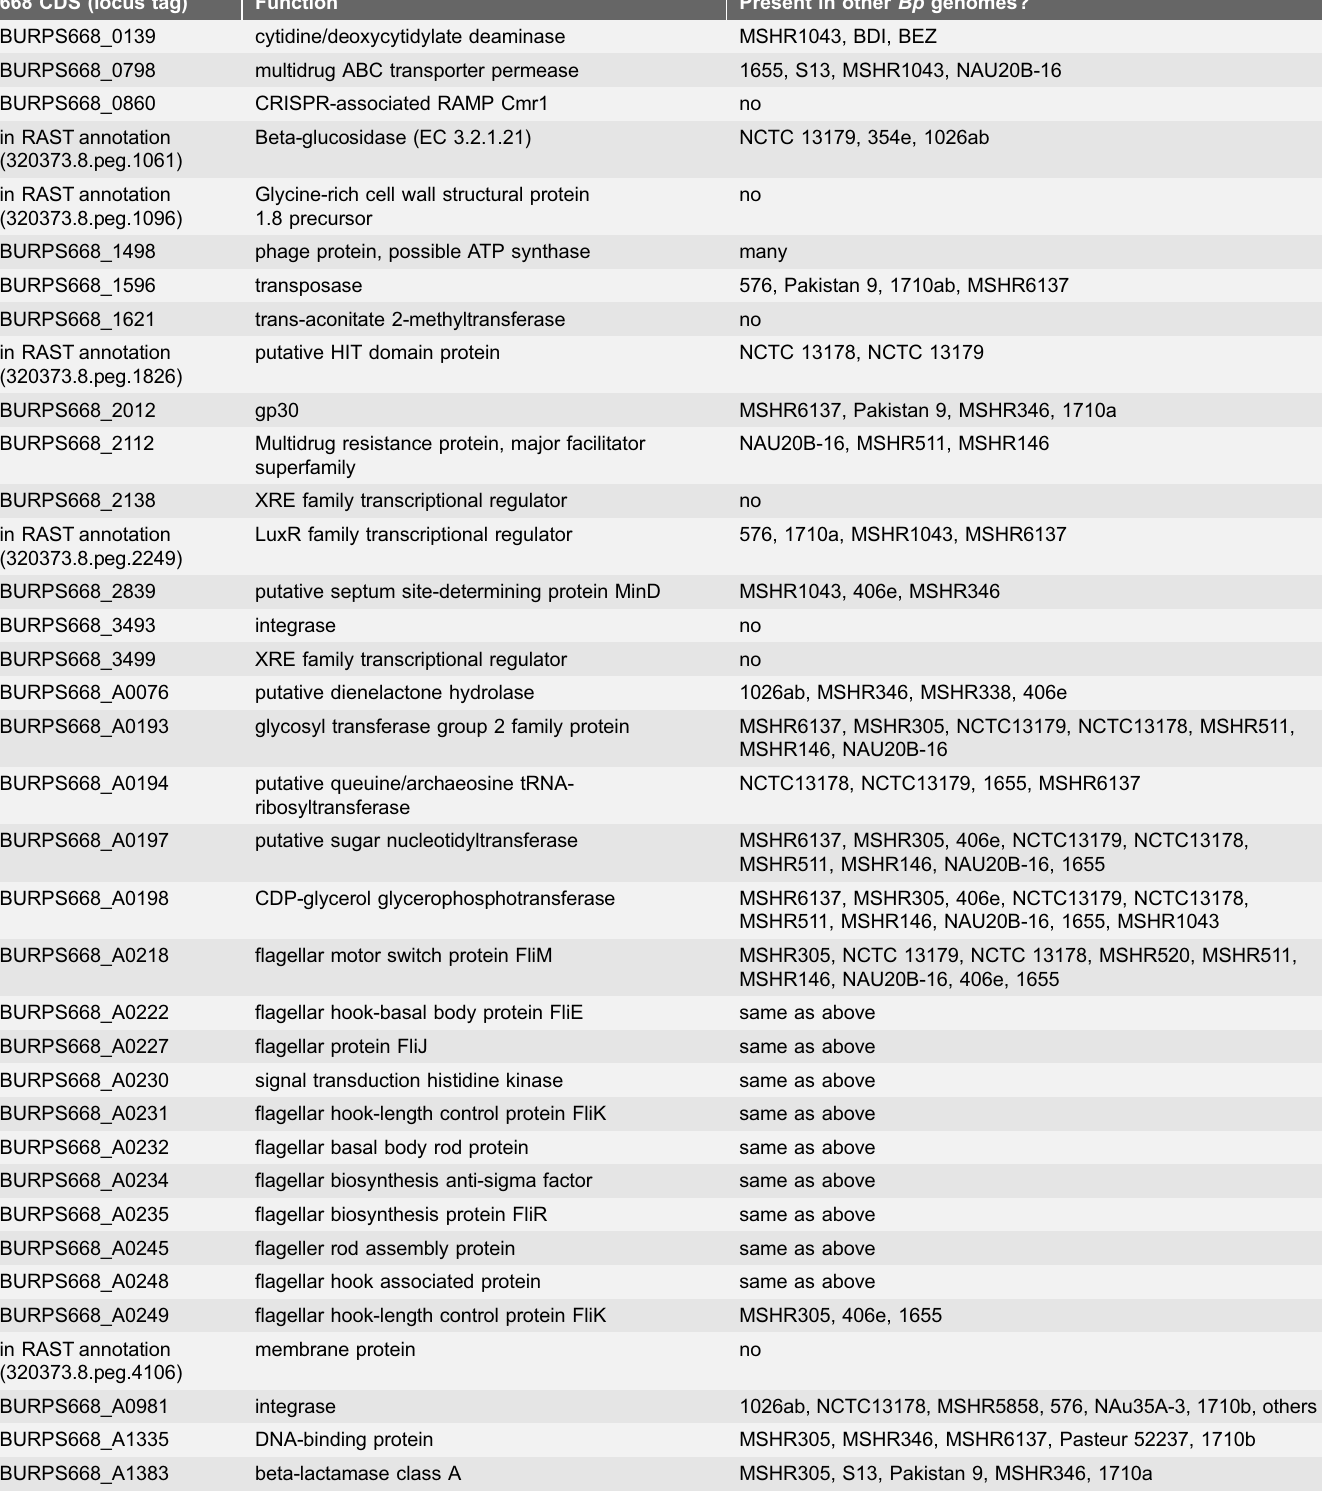
Table 3. Genes present in the MSHR668 genome that were absent in both K96243 and 1106a. 668 CDS (locus tag)